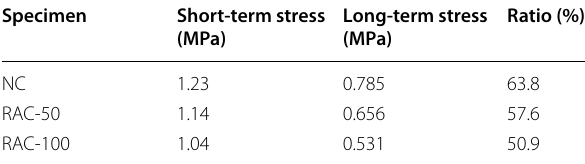
Table 5 Experimental results for concrete tensile stresses Specimen